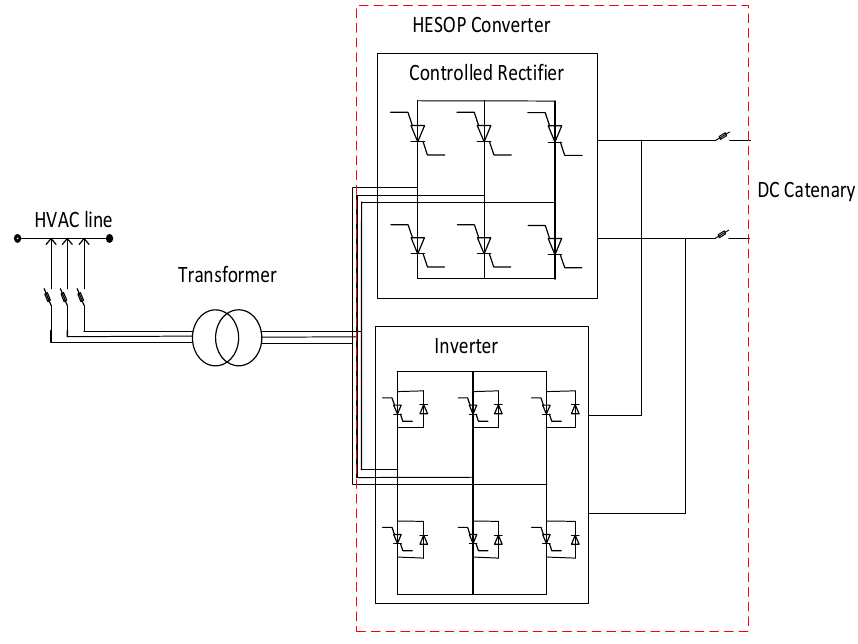
Figure 17. Harmonic and energy-saving optimizer (HESOP) converter [101].